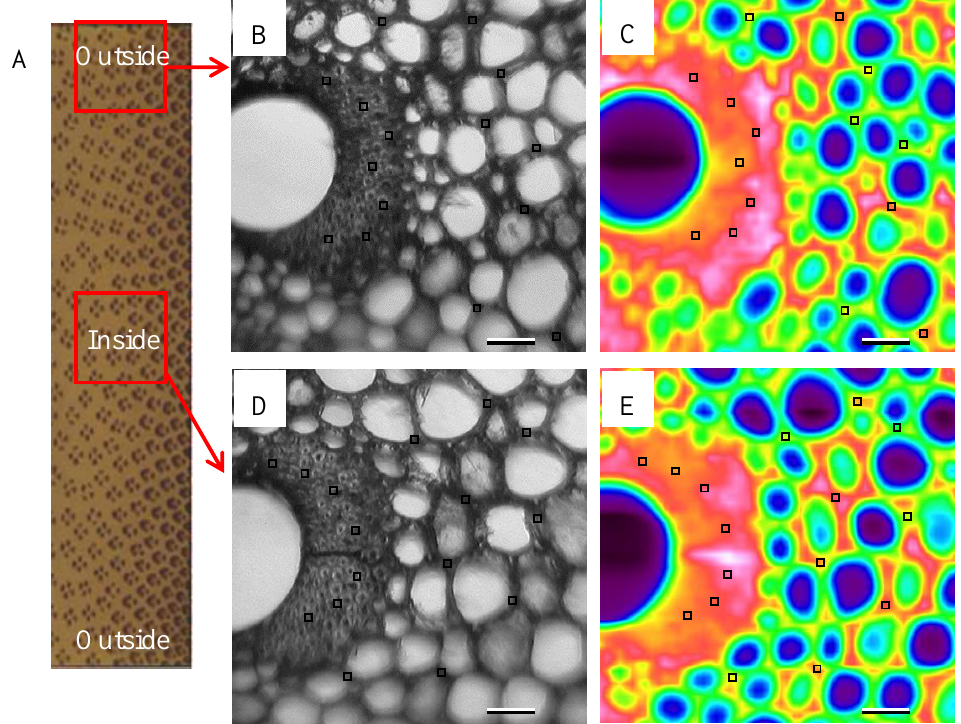
Figure 2. Schematic image of the sampling area for the imaging Fourier transform infrared spectroscopy microscopy (FT-IR) experiment ( A ), and the cross section is in the middle of the furfurylated bamboo samples. Visible-light microscopy image of the test area near the surface of the treated bamboo ( B ), and the test area inside the treated bamboo ( D ). Corrected total full-spectral IR absorbance image of the test area near the surface of the treated bamboo ( C ), and the test area inside the treated bamboo ( E ). The small black empty box indicates the typical pixel position corresponding to the position for the measurement of cell wall spectra. The scale bar = 50 µ